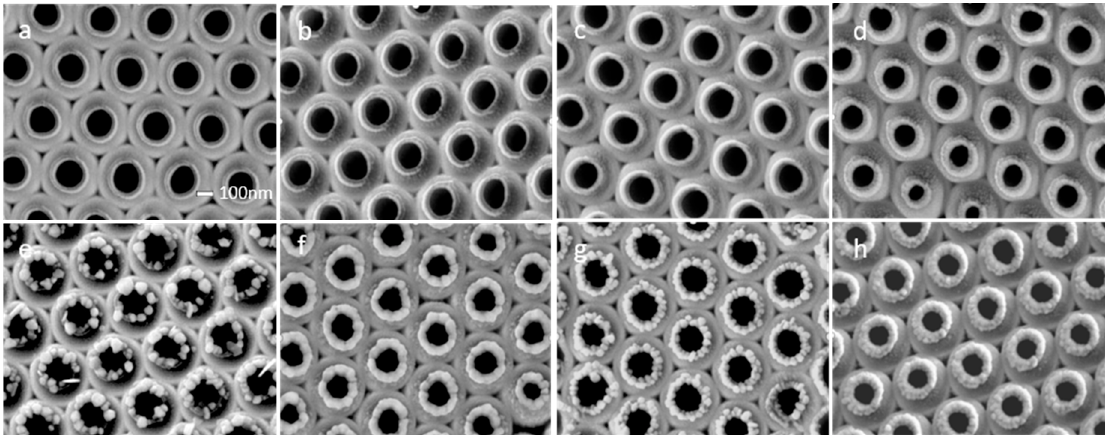
Figure 3. The 70° tilt sputtering (Au) of the nanojar structure after 30 s etching. The sputtering time was ( a ) 15 s, ( b ) 30 s, ( c ) 45 s, and ( d ) 60 s. Reuse of local surface plasmon resonance (LSPR)-assisted